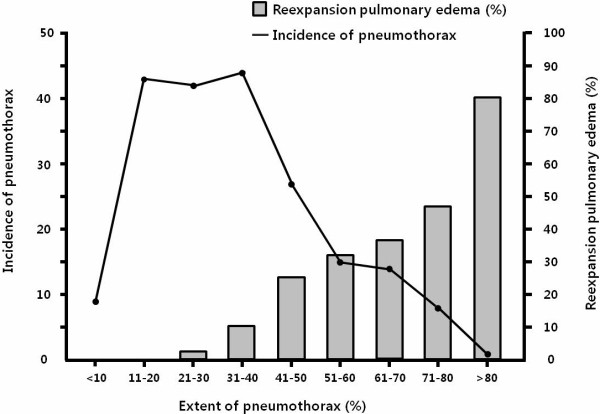
The incidence of reexpansion pulmonary edema (REPE) increased with the size of pneumothorax. Gray rectangle, proportion of REPE; Black line, incidence of pneumothorax.